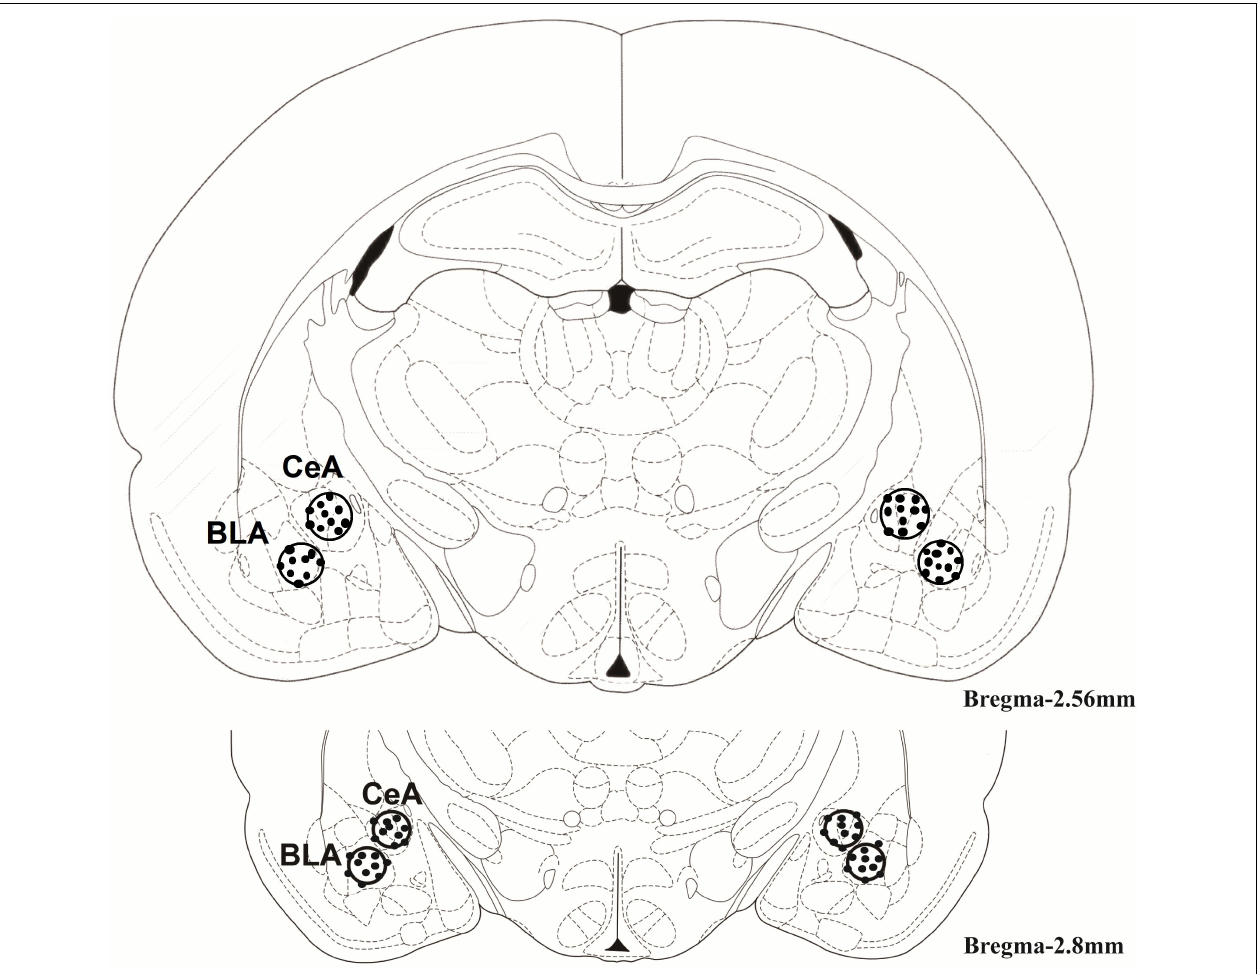
FIGURE 1 | The regions of the basolateral amygdala [basolateral amygdala (BLA): –2.8 mm from bregma] and central amygdala [central amygdala (CeA): –2.8 mm from bregma]. The cannula was placed into them as shown in the rostral faces of each coronal